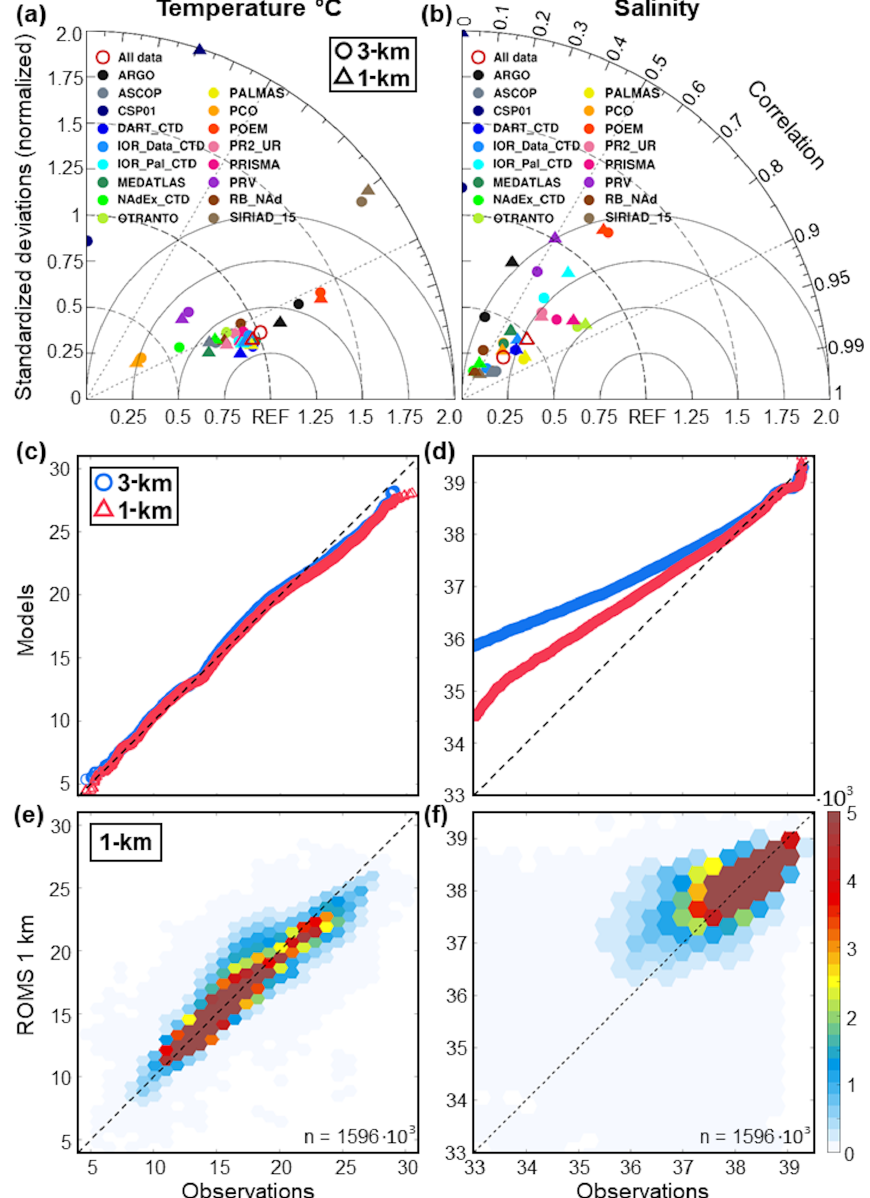
Figure 6. Evaluation of the AdriSC ROMS 3km and 1km temperature (a, c, e) and salinity (b, d, f) results against observations from 17 different datasets with (a, b) Taylor diagrams and (c, d) quantile–quantile plots as well as, only for the 1km model, (e, f) scatter plots showing the density (number of occurrences) with hexagonal bins and total number of points n